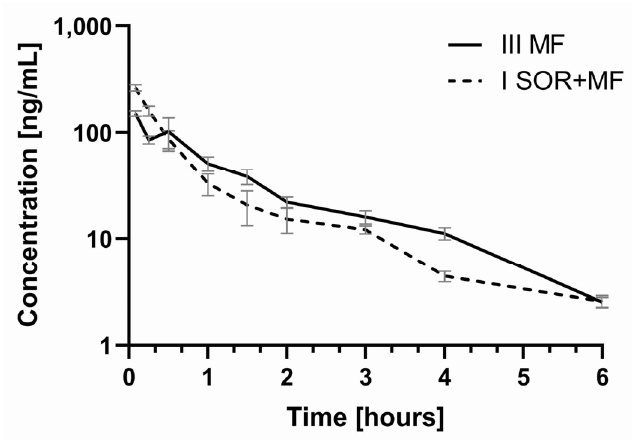
Figure 3. The morphine plasma concentration–time profiles in rats receiving morphine (III MF ) and sorafenib + morphine (I SOR+MF ).